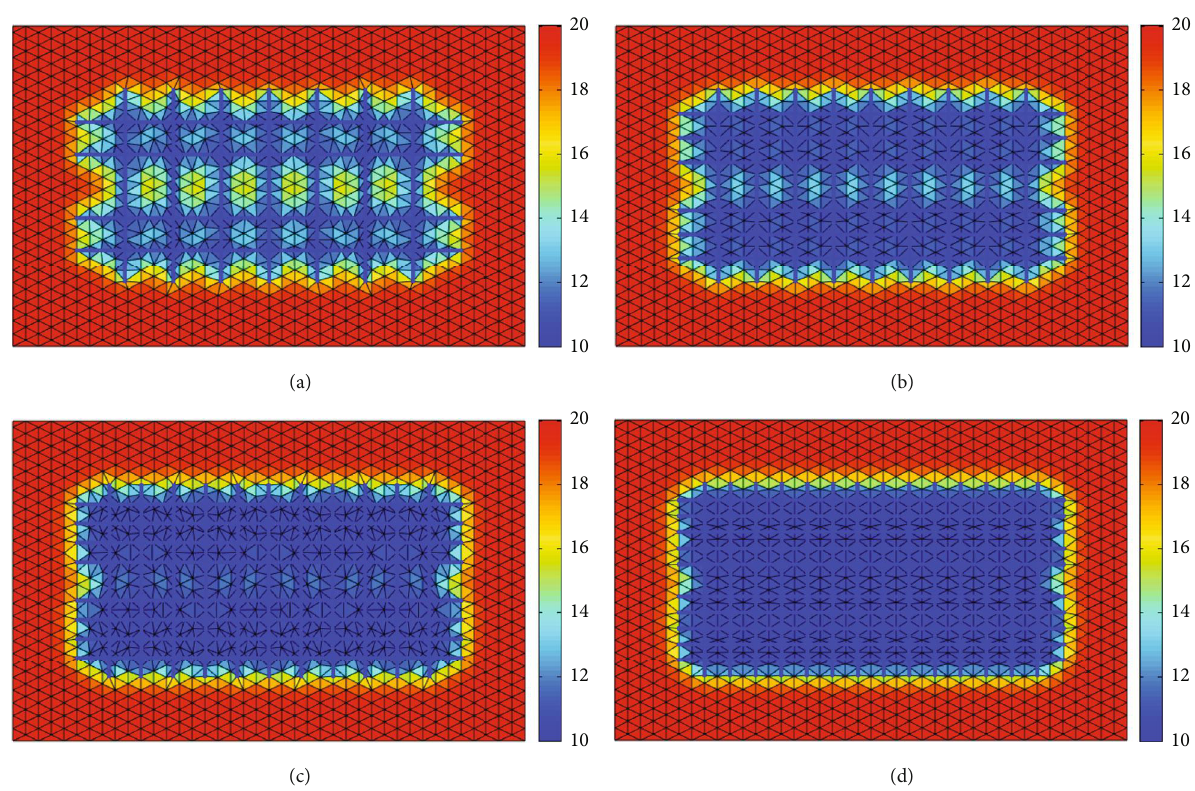
Figure 2: Reservoir pressure pro fi les at t = 50 days: (a) FD = 0 : 05 ; (b) FD = 0 : 07 ; (c) FD = 0 : 09 ; (d) FD = 0 : 11 .